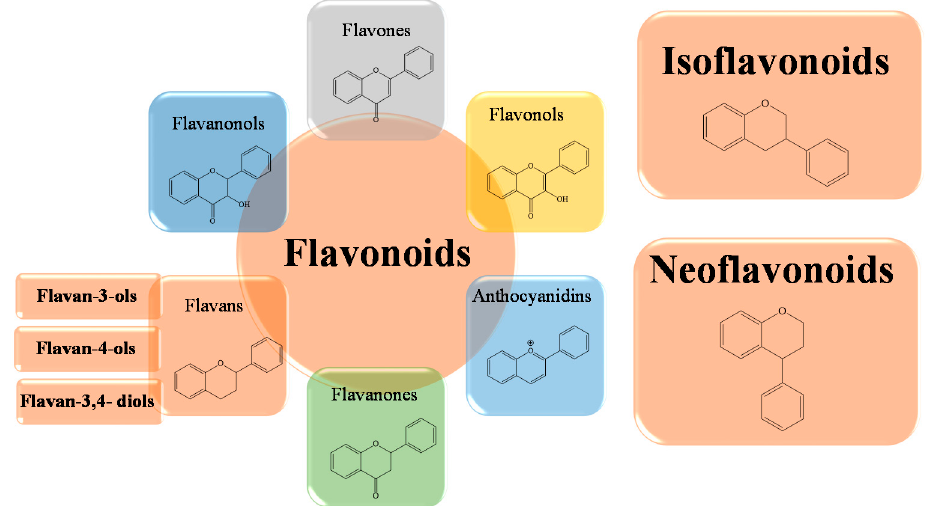
Figure 2. Schematic representation of the basic structures of flavonoid subclasses.